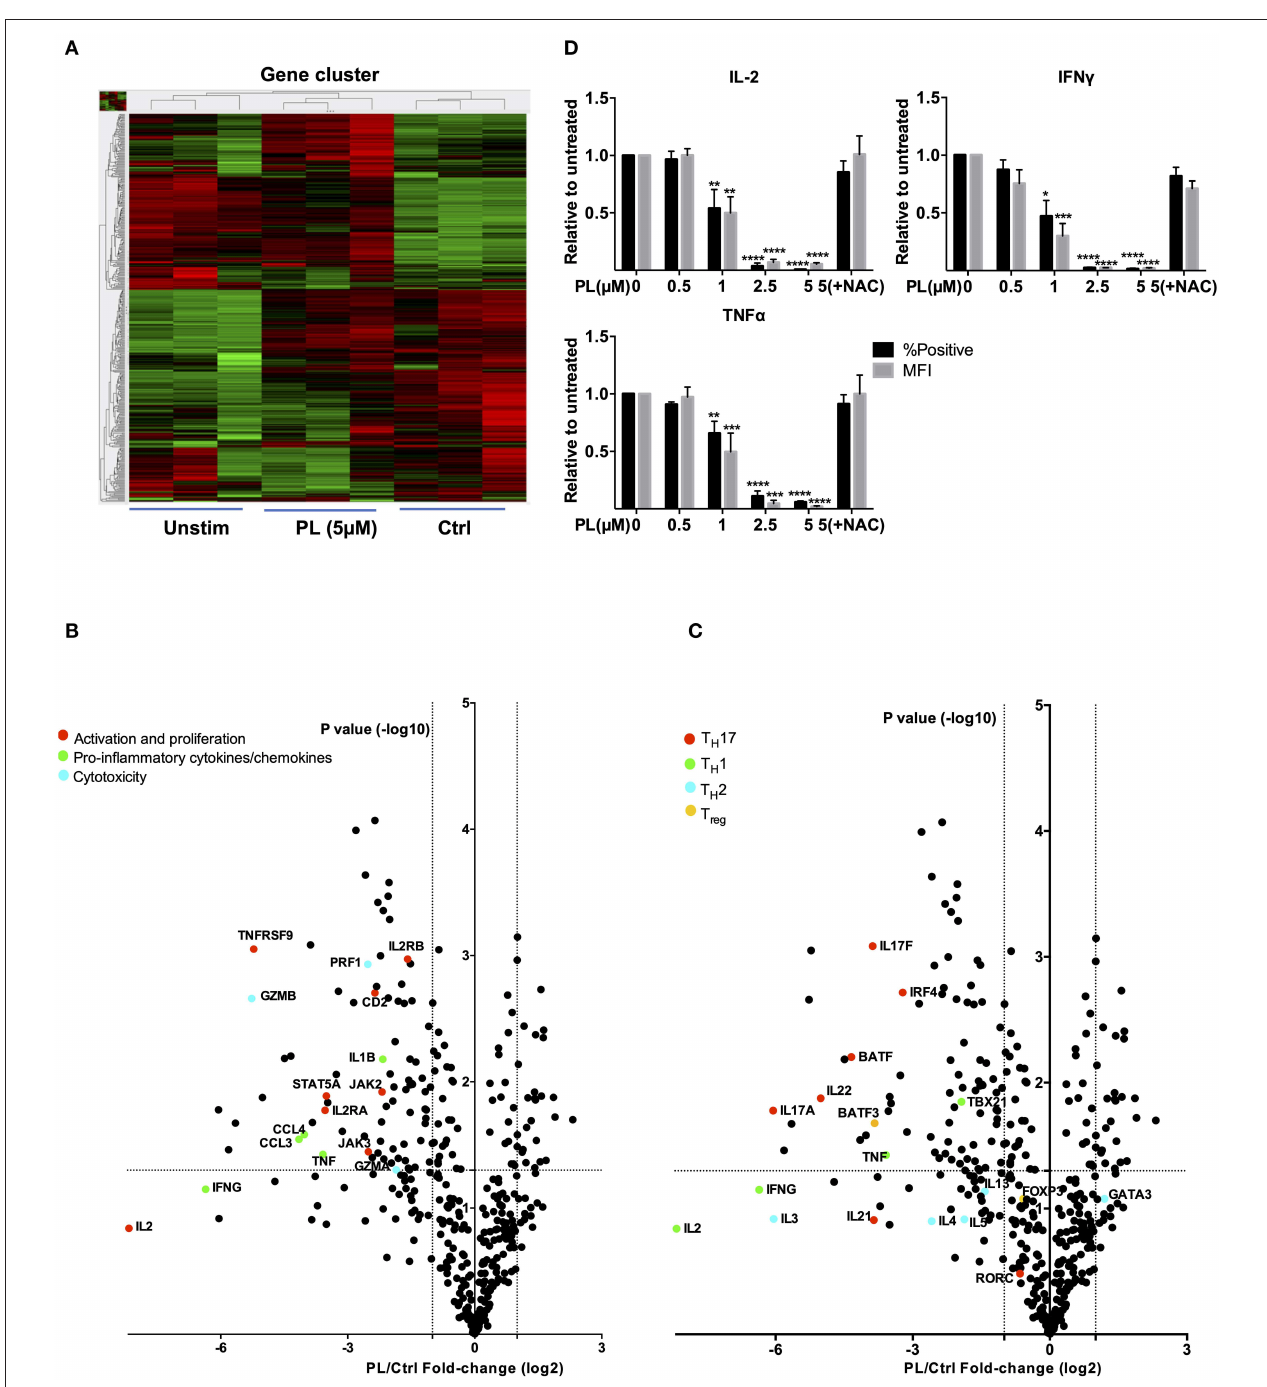
FIGURE 5 | Gene expression analysis (nCounter®) and intracellular cytokine staining. (A) Hierarchical clustering of differentially expressed mRNAs in T cells which were unstimulated (Unstim), anti-CD3/CD28 antibodies stimulated with PL (PL 5 µ M) or without PL (Ctrl) treatment. Each column represents an individual sample ( n = 3). Relative change is indicated by the color scale (red: high; green: low). (B,C) Volcano plots show differentially expressed genes (B) important for T cell activation and cytokines and (C) related to T H 1, T H 2, T reg , and T H 17 cells. Log 2 transformed fold-change in expression (PL vs. Control) on the x-axis is plotted against significance [–log10 ( p -value)] on the y-axis. The horizontal and vertical dashed lines indicate cutoff for significance p < 0.05 ( − log10 p-value > 1.3) and for fold-change ≥ 2/ ≤− 2, respectively. (D) Protein levels of IFN γ , TNF α and IL-2 were detected by intracellular cytokine staining. Shown are ratios of PL-treated cells to the control with regard to the % positive cells (black bars) and MFI (gray bars) ( n = 3; mean; SEM; * p < 0.05, ** p < 0.01, *** p < 0.001, **** p < 0.0001).